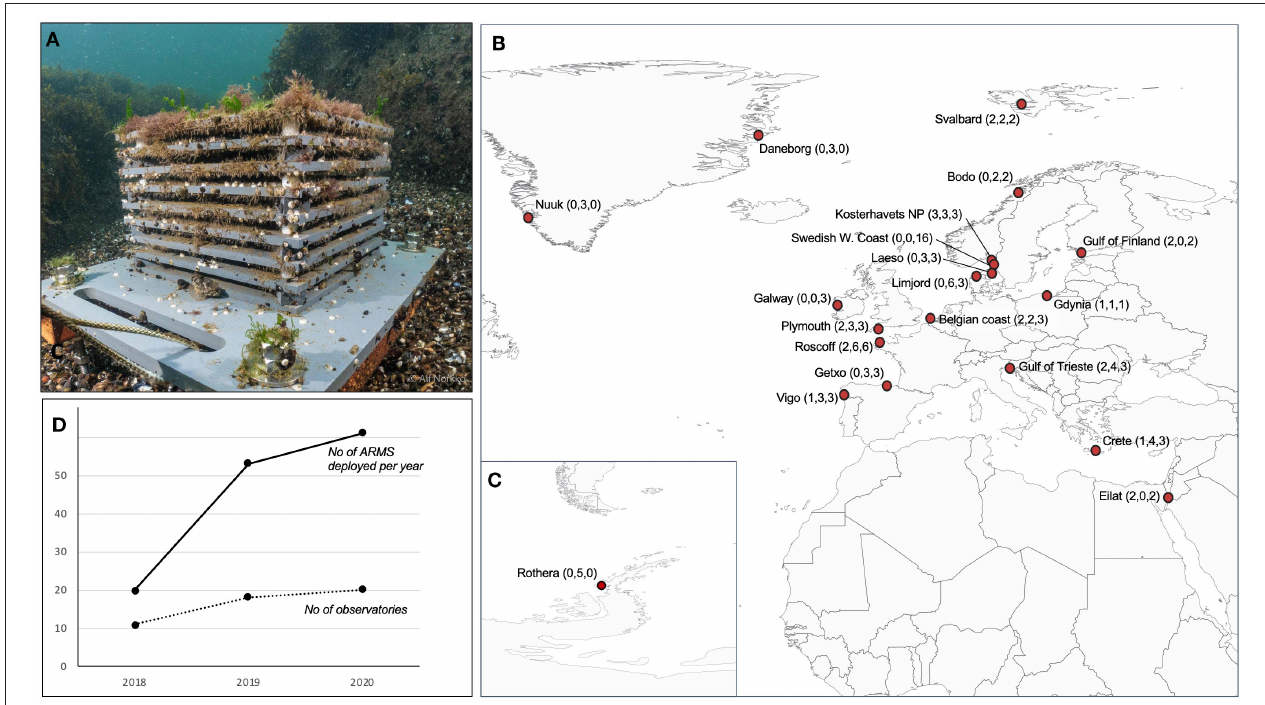
FIGURE 1 | Overview of the ARMS-MBON observatories. (A) Deployed ARMS; (B,C) Geographical overview of currently established observatories. (D) Growth metrics of the network over time (for details see Supplementary Table 1 ). Numbers in parentheses (B,C) indicate the number of ARMS deployed in 2018, 2019, and 2020,